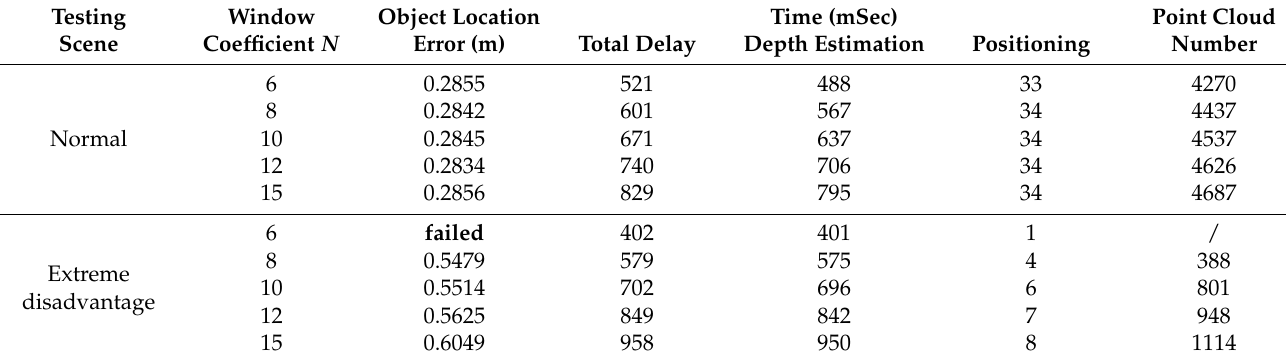
Table 5. Testing on sliding window